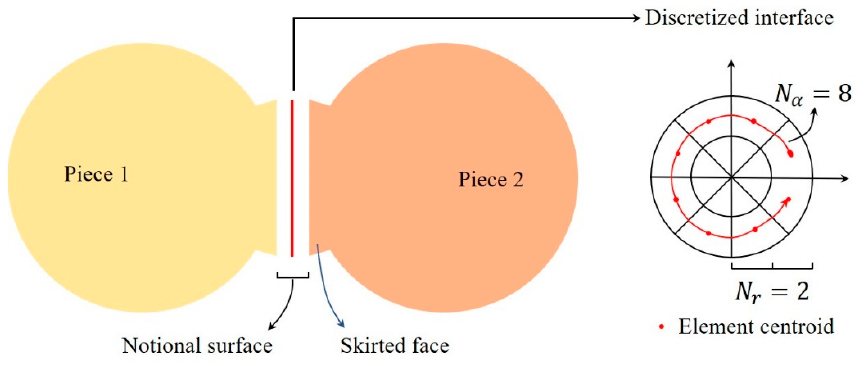
Figur e 7 . A typical flat-joint contact